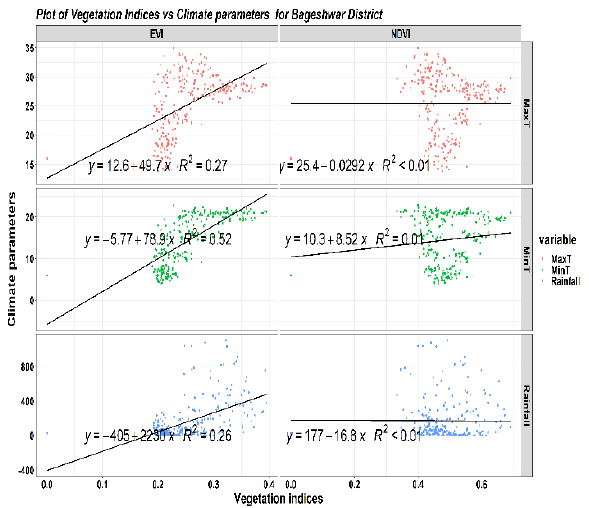
Figure 12. Scatter Plot between Vegetation Indices and Climate Parameters for Bageshwar District